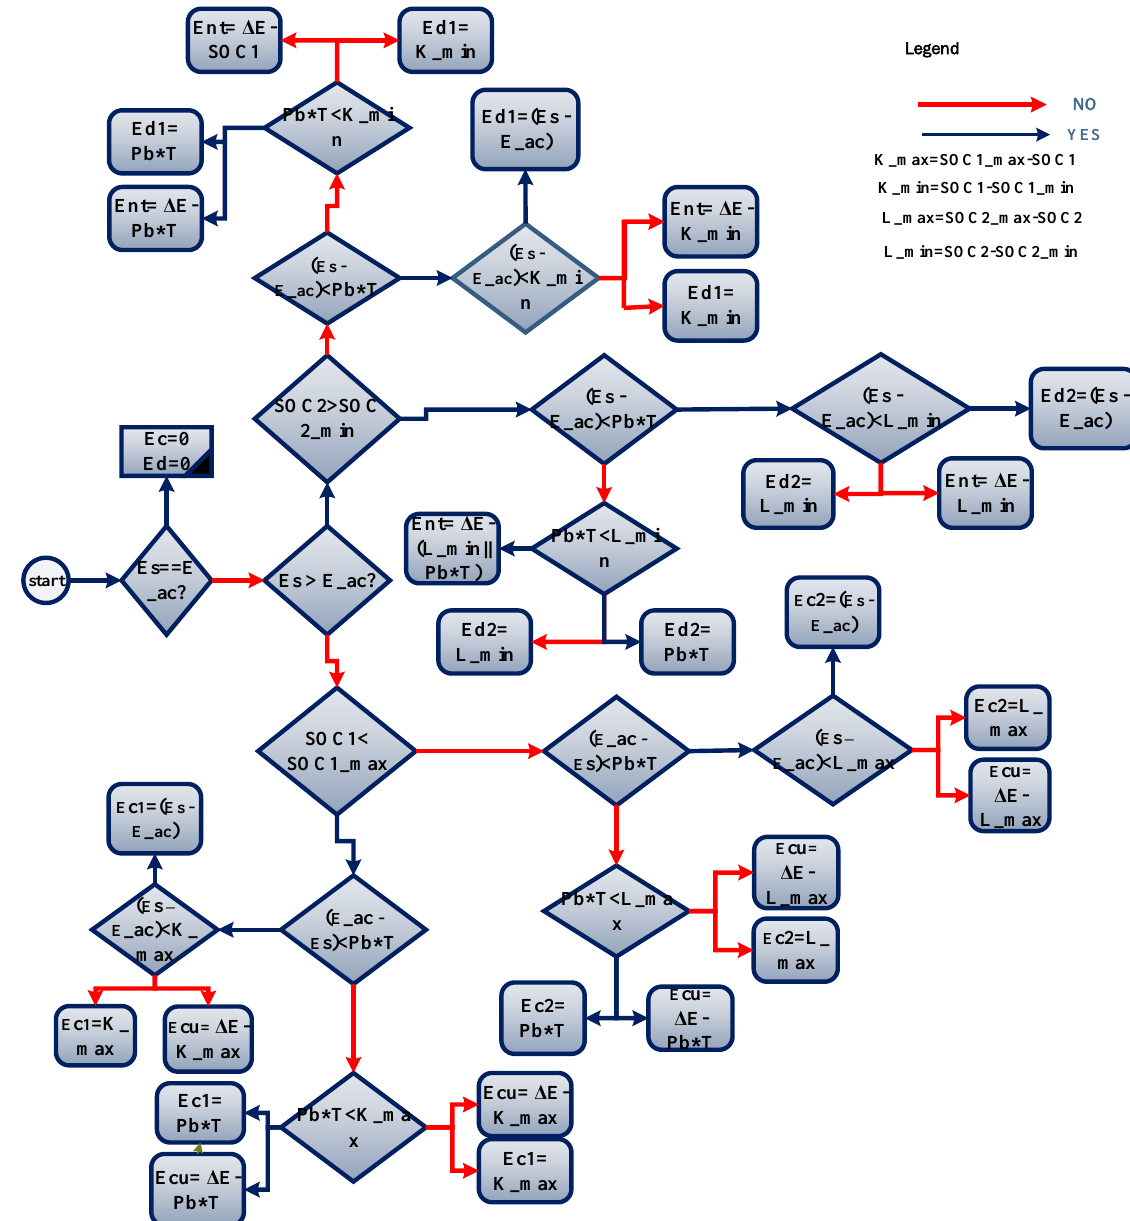
Figure 6. Control algorithm of simultaneous state exchanging strategy.